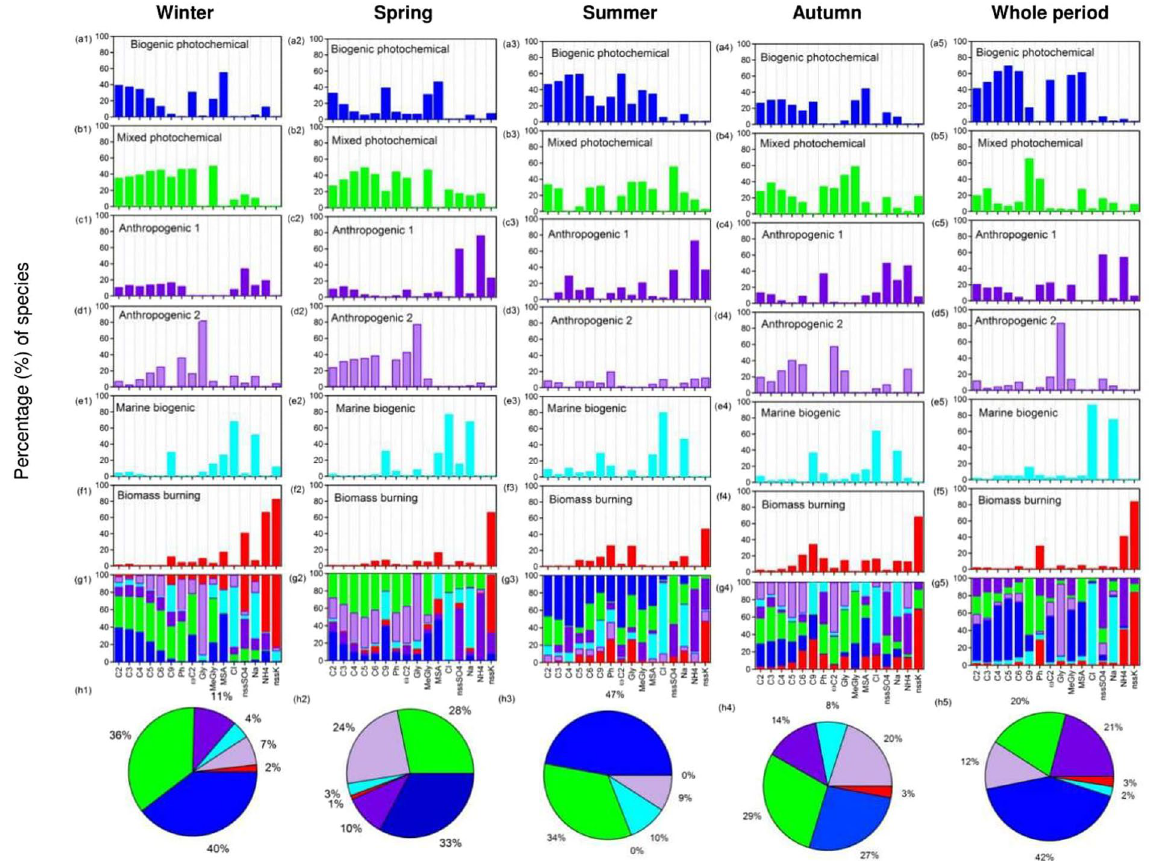
Figure 4. The PMF derived explained variance (%) for the source profiles for the different seasons as well as the whole period (2001–2013) during the study ( a – f ). Contributions of each source profile to individual acids ( g ) and oxalic acid ( h ) for the different seasons over the WNP. Each color indicates the different source as mentioned in plots a-f. Therefore, for interpretation of the colors in plots g and h, the reader is referred to the color version of this